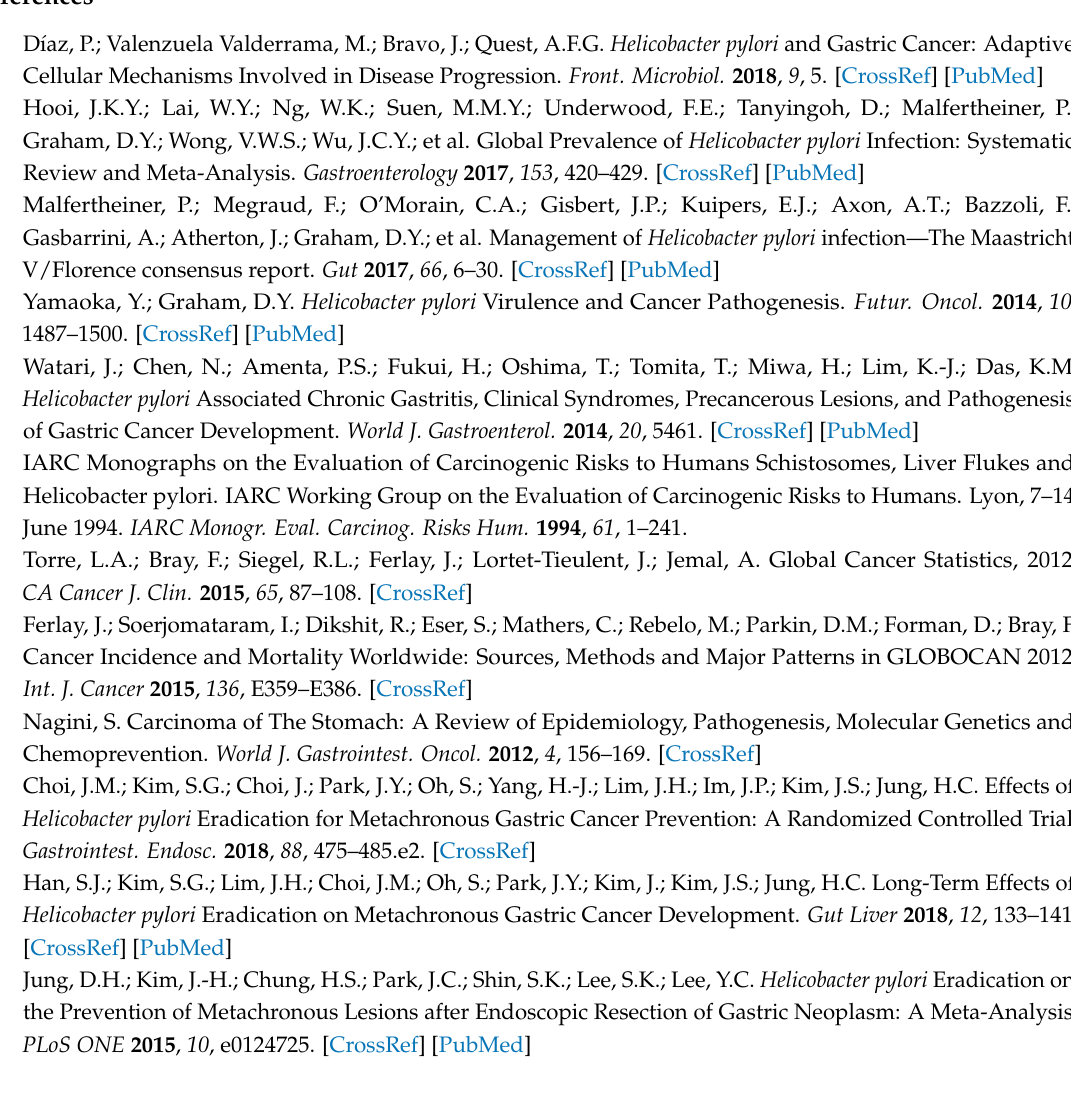
Table S11: The morphology of H. pylori T30a after a 3-day incubation with 3-BP and CLR during the checkerboard assay, Table S12: The morphology of H. pylori T30a after a 3-day incubation with 3-BP and TET during the checkerboard assay, Table S13: The morphology of H. pylori T30a after a 3-day incubation with 3-BP and AMX during the checkerboard assay, Table S14: The morphology of H. pylori T30a after a 3-day incubation with 3-BP and MTZ during the checkerboard assay, Table S15: The morphology of H. pylori 7143 after a 3-day